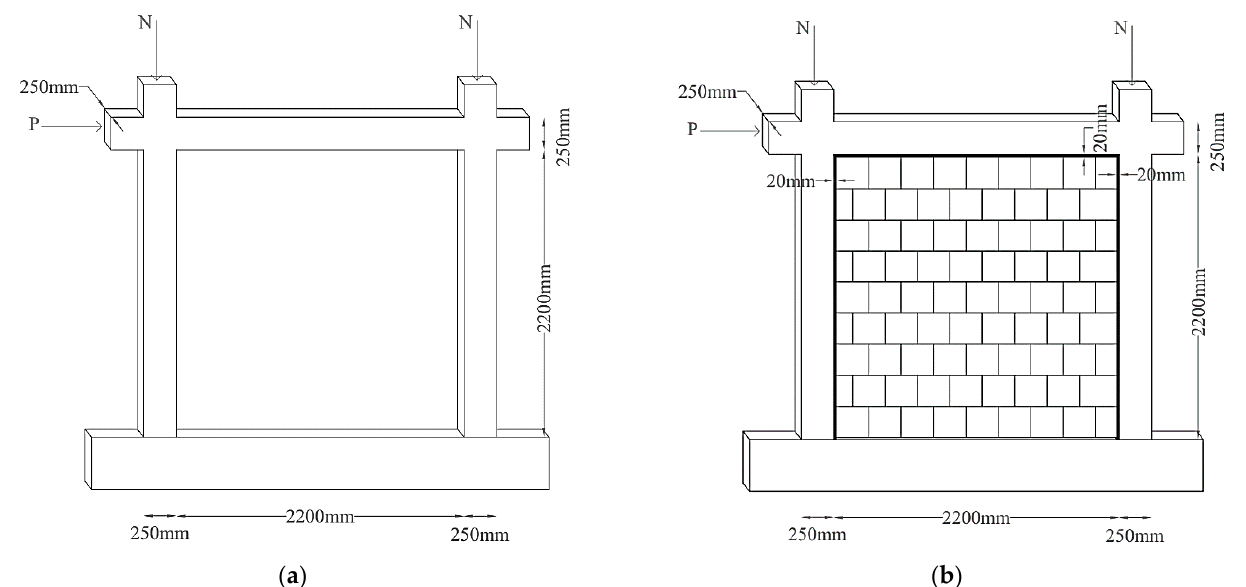
Figure 9. ( a ) Dimensions of the RC frame; ( b ) Specimen B2 with polymer joint applied on the 3 interfaces of the existing infill with the 2 concrete columns and the top beam.